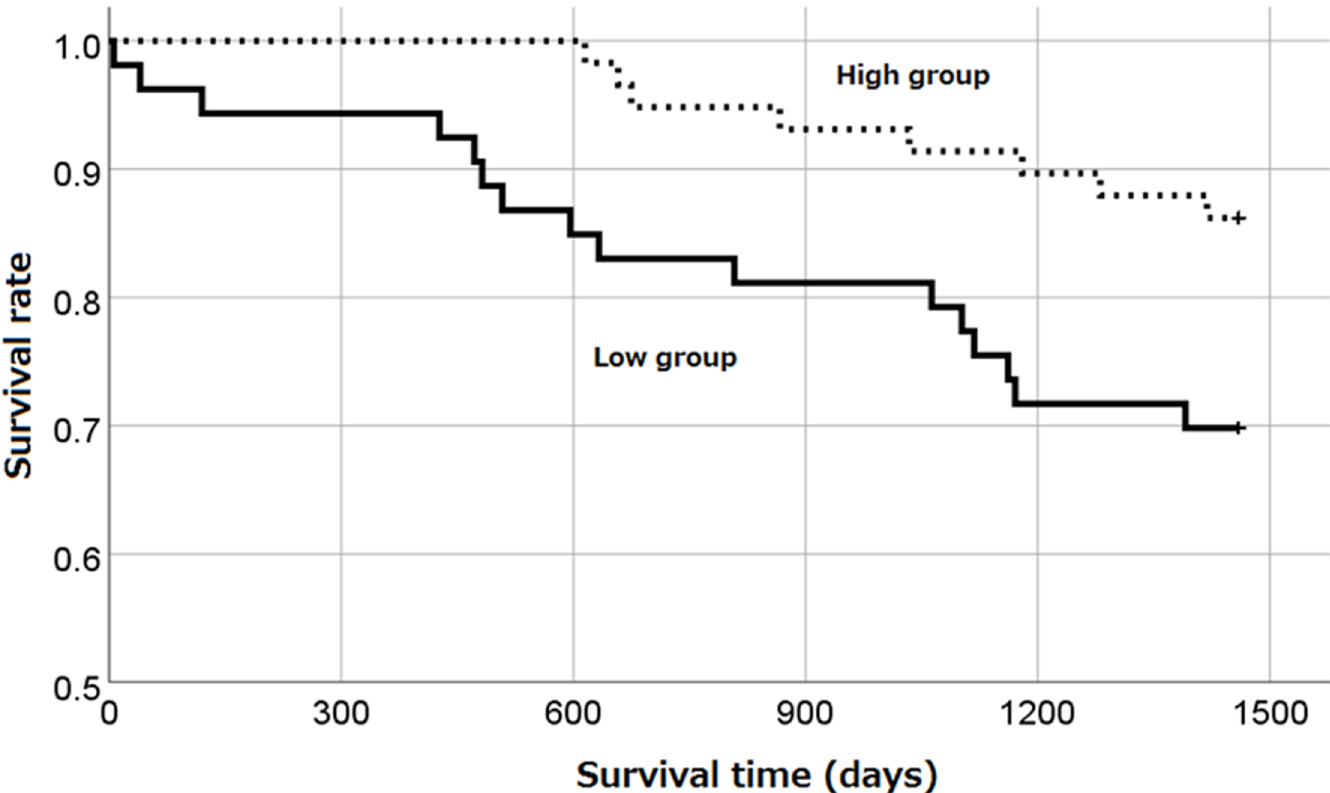
Fig 1. The survival probabilities of hemodialysis patients in high C2/(C16+C18:1) group or low C2/(C16+C18:1) group (log-rank test, P = 0.027. Breslow test, P = 0.021).